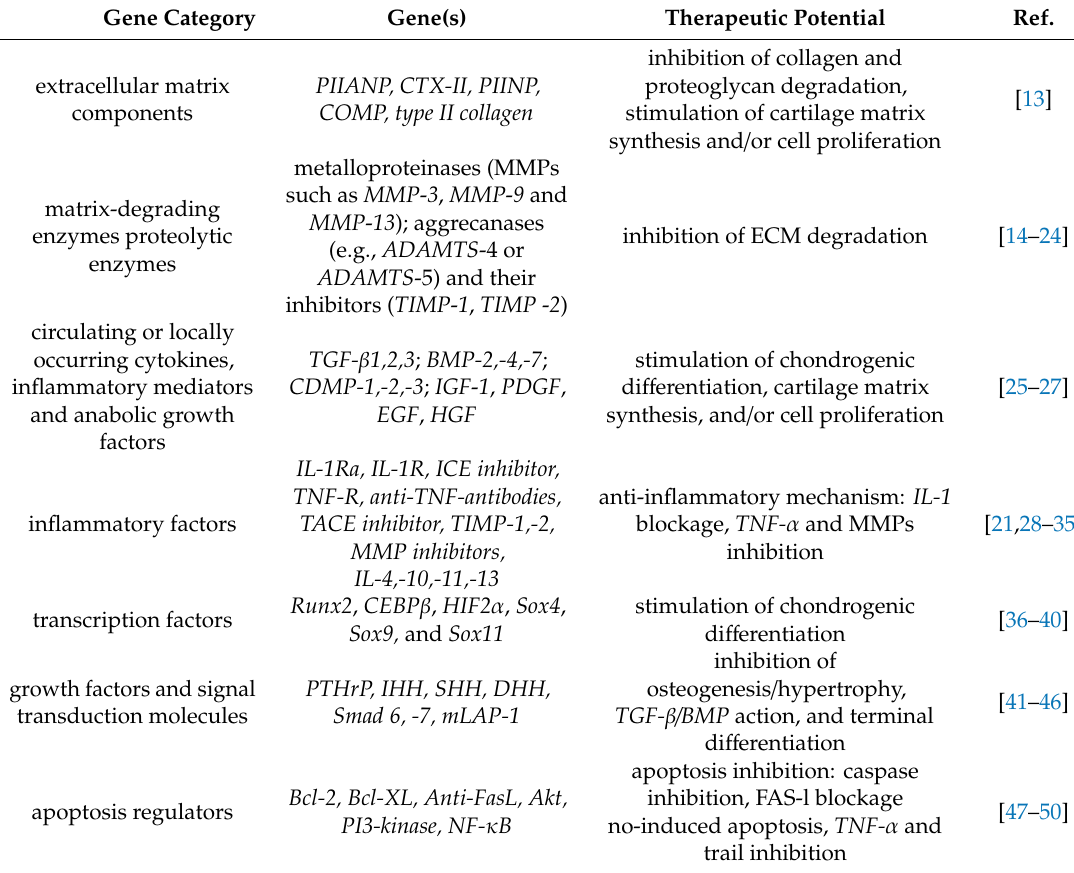
Table 1. Summary of biomarkers of cartilage damage showing the potential to support regenerative therapy. ECM: extracellular